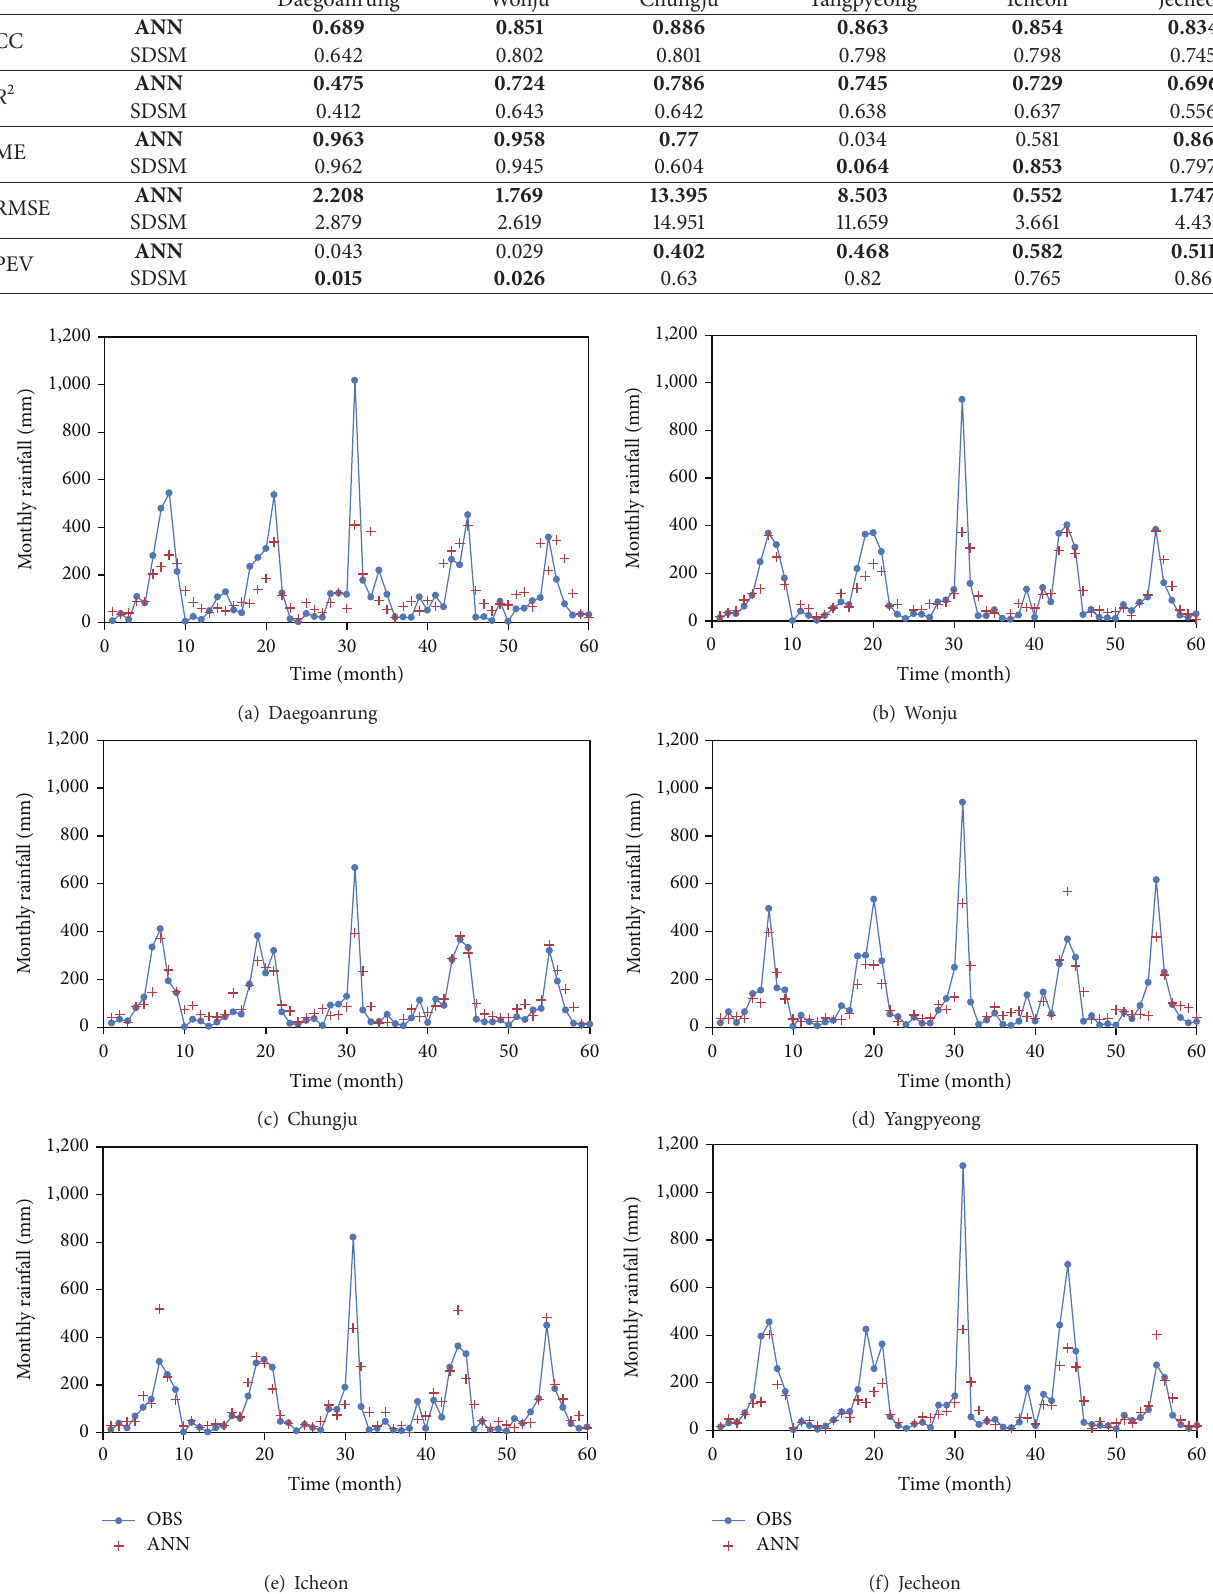
Figure 5: Comparison of rainfall series for the verification period in the Namhan river